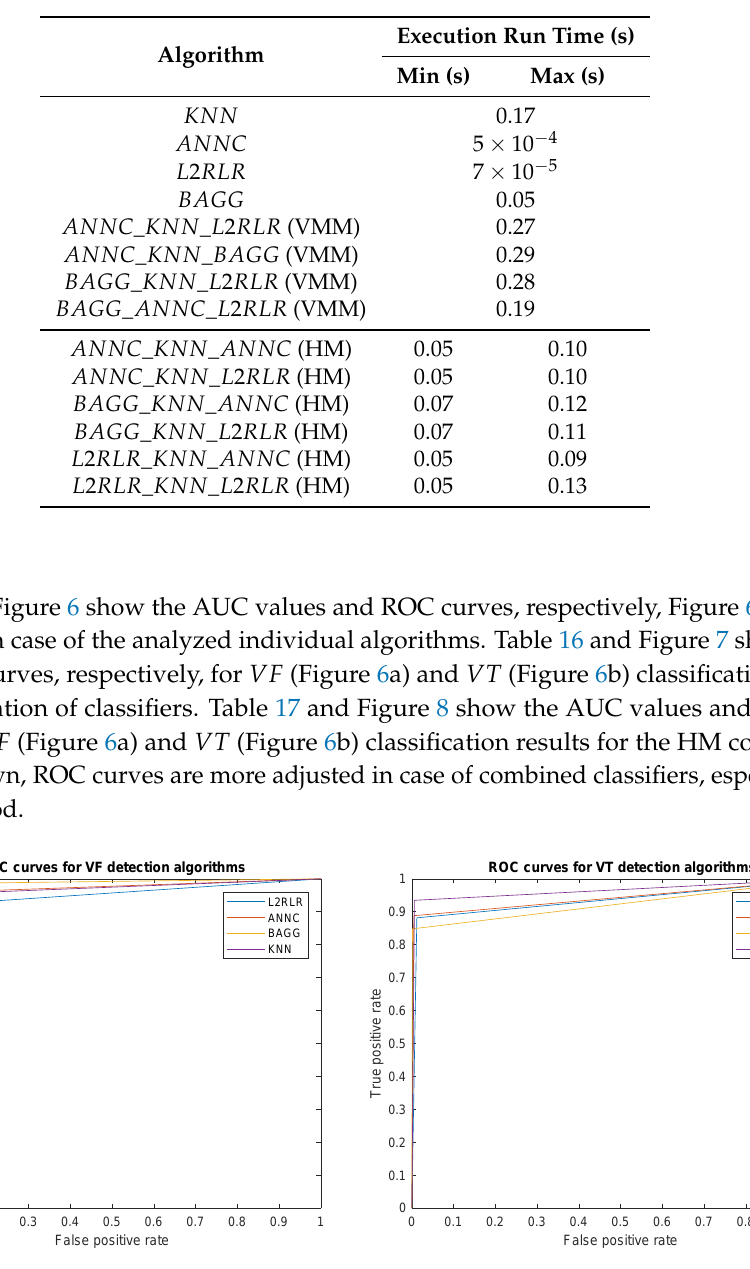
Table 14. Results of the average execution run time for each data window t w obtained using individual and combined classification algorithms.